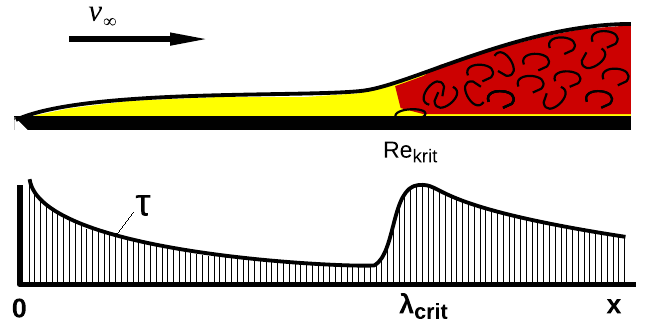
Figure 5. Development of the boundary layer along a flat plate with laminar-turbulent changeover ( top ) and local shear stress on the plate ( bottom ).